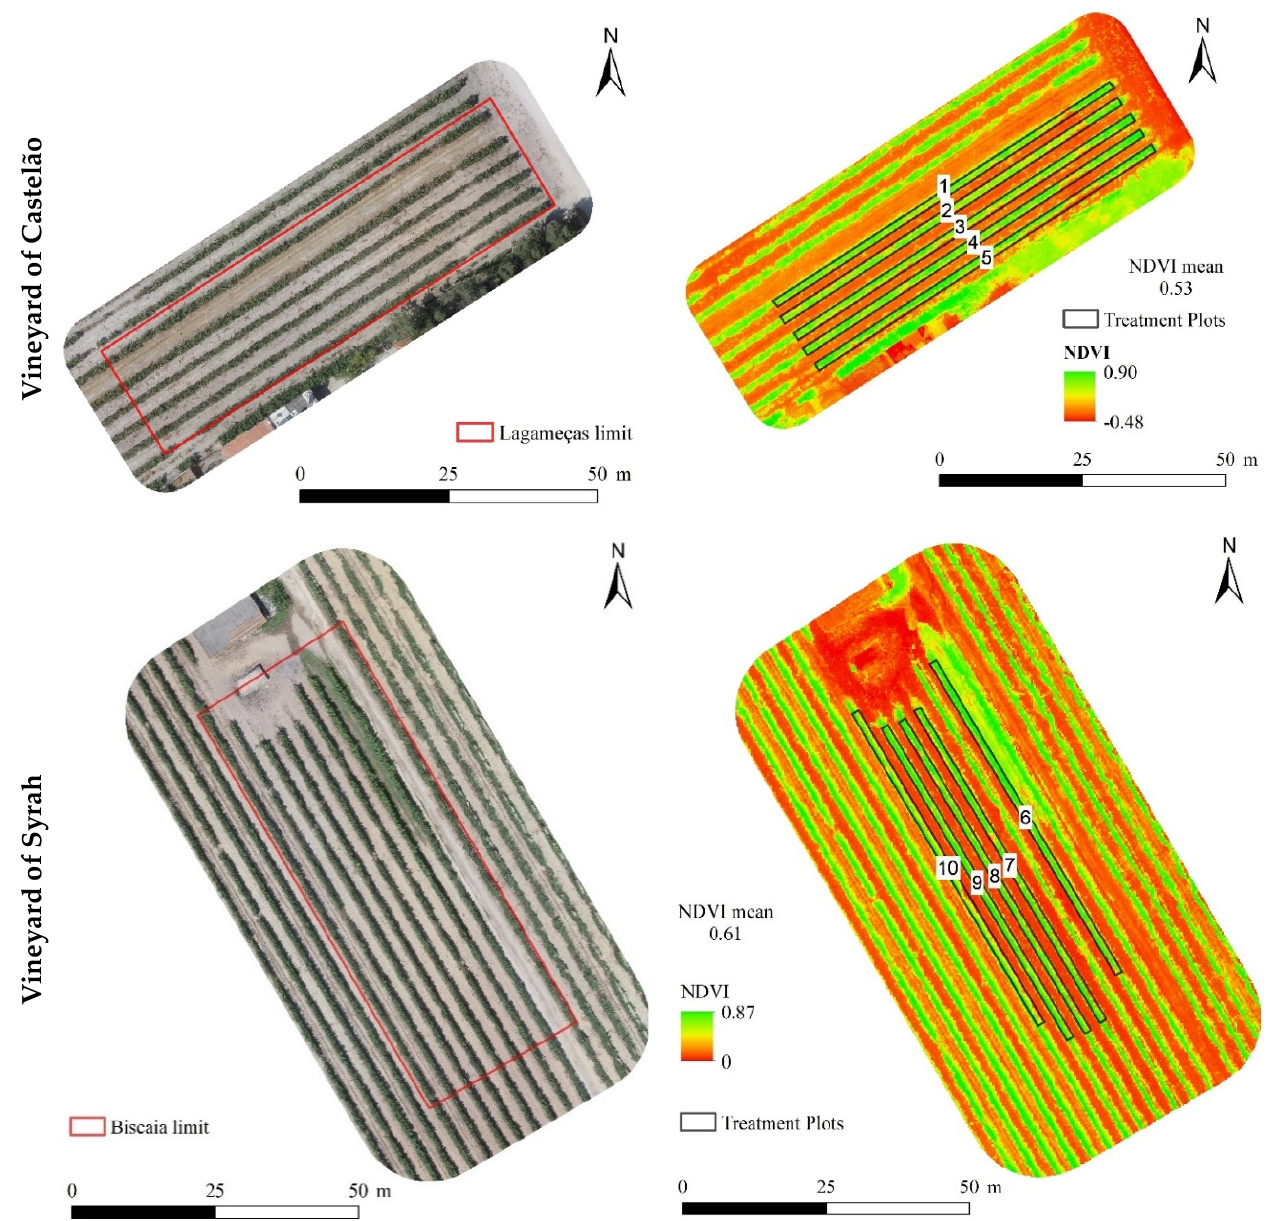
Figure 2. Orthophoto maps and normalized di ff erence vegetation index (NDVI) of the vineyards of Castelão and Syrah. Information collected after the 4th foliar application of ZnSO 4 or ZnO on 22 August 2019. Castelão: 1—control; 2—ZnO (900 g ha ─ 1 ); 3—ZnO (1350 g ha ─ 1 ); 4—ZnSO 4 (900 g ha ─ 1 ) and 5—ZnSO 4 (900 g ha ─ 1 ). Syrah: 6—control; 7—ZnO (900 g ha ─ 1 ); 8—ZnO (1350 g ha ─ 1 ); 9—ZnSO 4 (900 g ha ─ 1 ); 10—ZnSO 4 (900 g ha ─ 1 ). Table 1. Average ± S.D. of normalized di ff erence vegetation index (NDVI) of the vineyards of Castelão and Syrah with ZnO and ZnSO 4 at di ff erent concentrations. Information collected after the 4th foliar application on 22 August 2019. Treatments Lagameças Field Biscaia Field Control